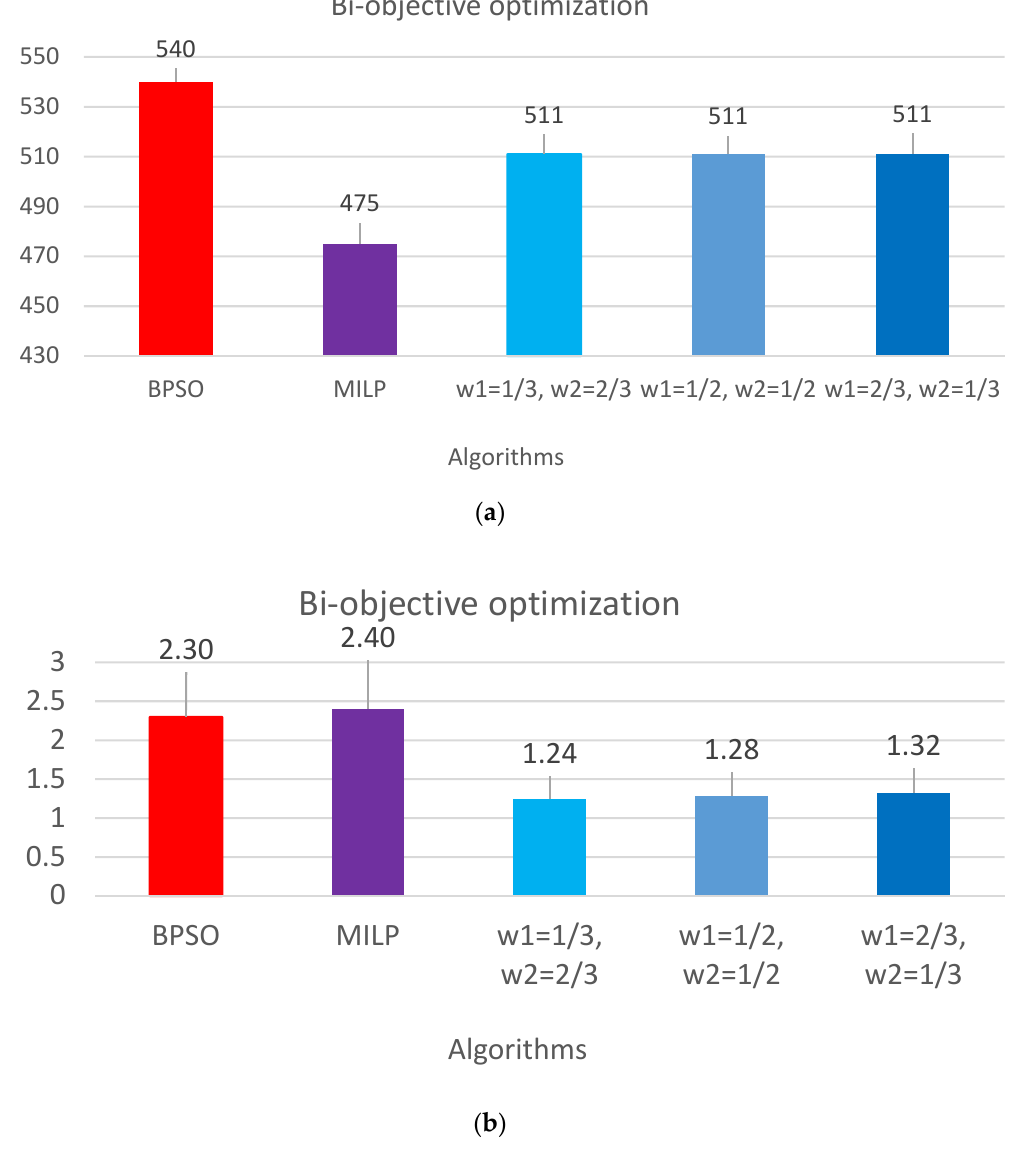
Figure 7. The comparison of the results with the previous ones [17]: ( a ) daily total cost, and ( b ) PAR.